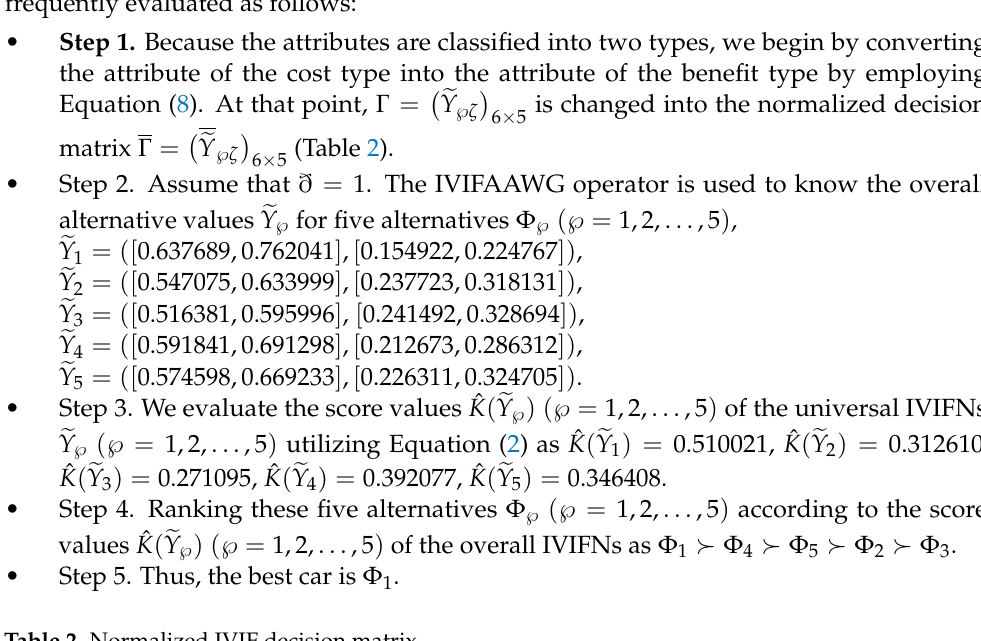
Table 2. Normalized IVIF decision